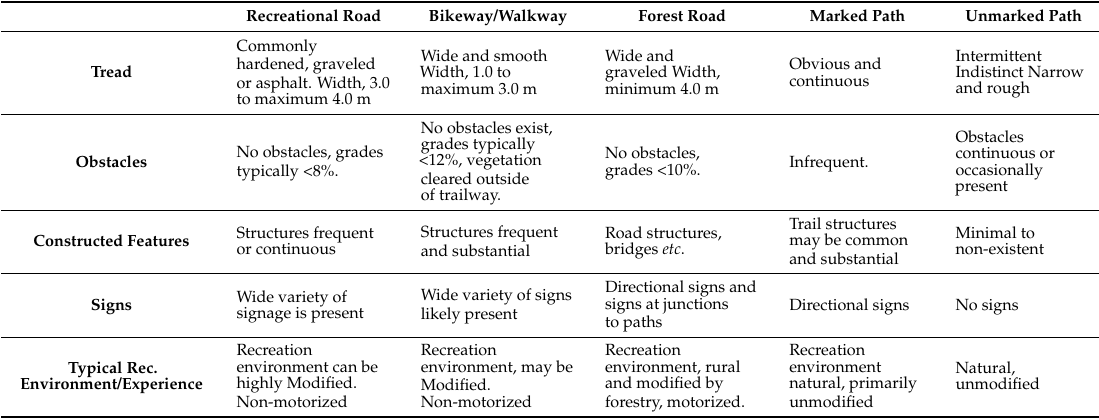
Table 1. Descriptions of the five infrastructure classes along the recreational continuum from developed to natural areas